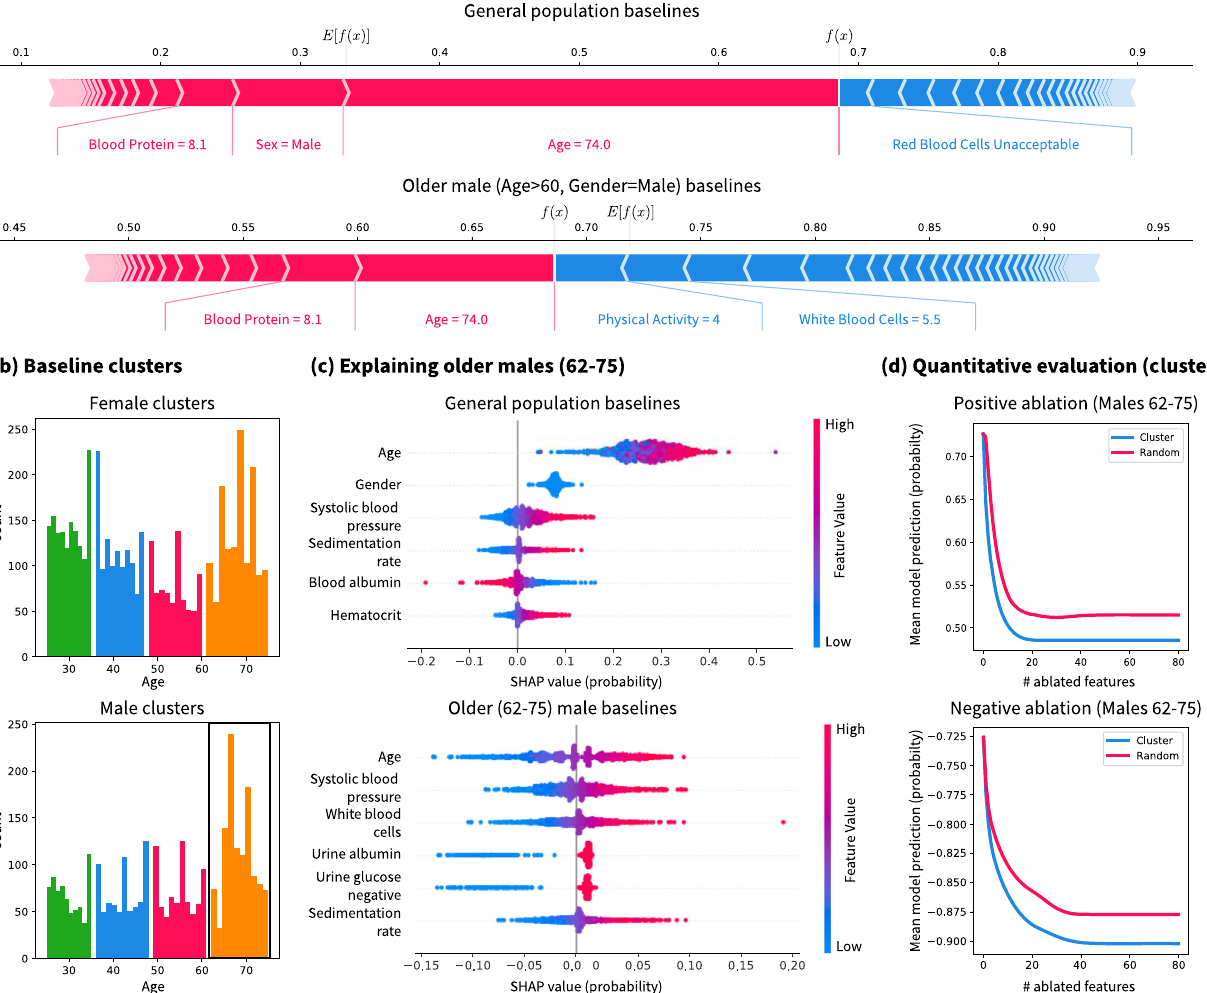
Fig. 3 The baseline distribution is an important parameter for model explanation. a Explaining an older male explicand with both a general population baseline distribution and an older male baseline distribution. Red colors denote positive attributions and blue denotes negative attributions. b Automatically fi nding baseline distributions using 8-means clustering on age and gender. Each cluster is shown in a different color. c Explaining the older male subpopulation (62 – 75 years old) with either a general population baseline or an older male baseline. d Quantitative evaluation of the feature attributions via positive and negative ablation tests where we mask with the mean of the older male subpopulation (the negative ablation test reports negative mean model output so that lower is better). Note that b shows summary plots (Supplementary Methods Section 1.3.3) and c shows dependence plots (Supplementary Methods Section